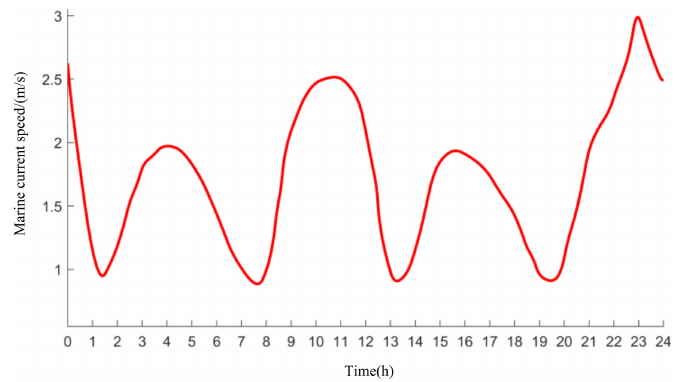
Figure 8. Tidal speed for 24 h.